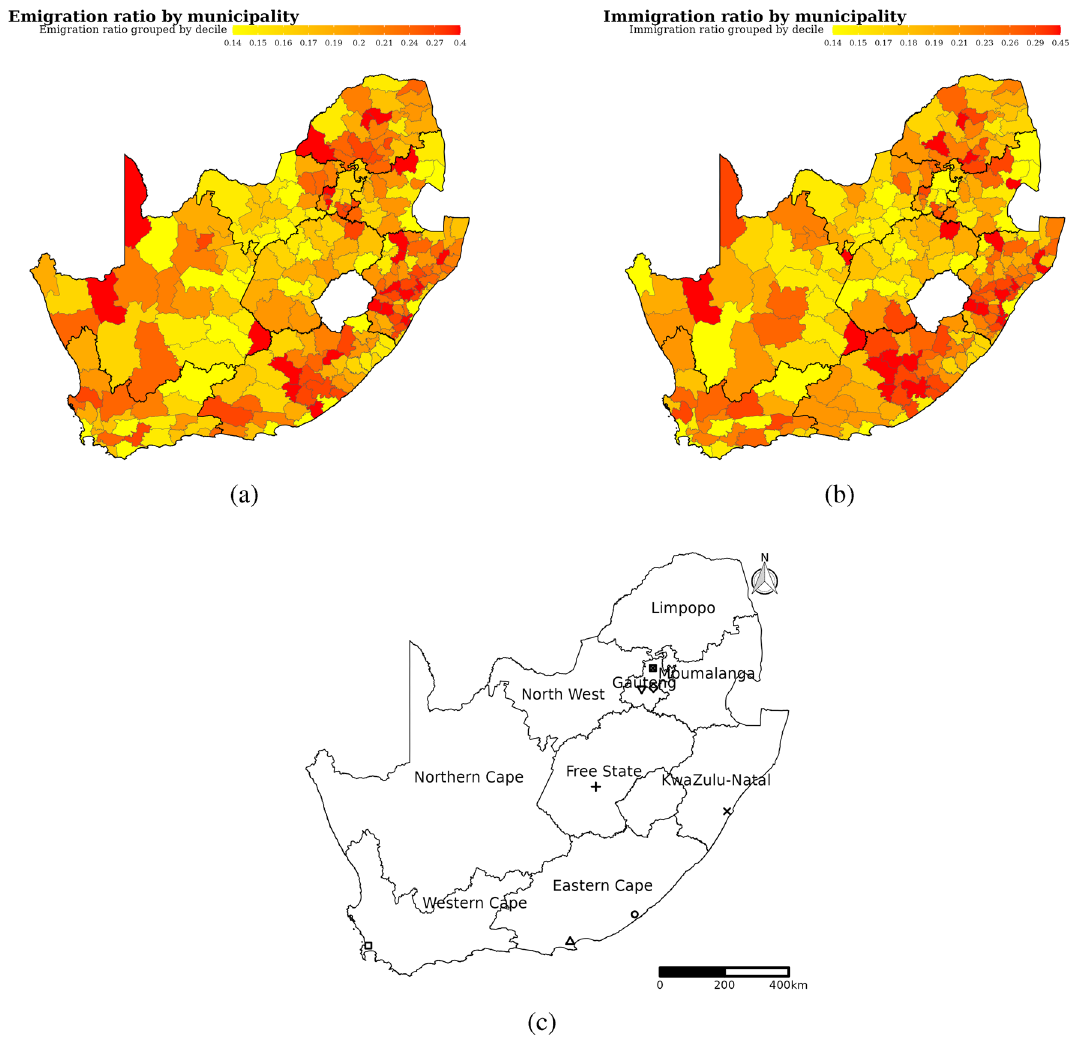
Figure 2. Emigration ( a ) and immigration ratios ( b ) by municipality among people with laboratory-diagnosed TB, and map of South Africa showing provincial boundaries and major cities ( c ). We calculated municipality- level emigration ratio as the share of outmigrants among people who initially visited a municipality, and immigration ratio as the share of in-migrants among all people who subsequently visited a municipality. We used laboratory tuberculosis test results, which were linked to identify individuals, from South Africa’s National Health Laboratory Service database to assess cross-municipality migration among people with laboratory- diagnosed tuberculosis. We defined migrants as people with laboratory-diagnosed tuberculosis who submitted tuberculosis test samples to clinics located in more than one municipality. The symbols in ( c ) are major cities in South Africa: Square, circle, triangle point up, plus, cross, diamond, triangle down, and square cross symbols are city of Cape town, Buffalo city, Nelson Mandela Bay, Mangaung, Ethekwini, Ekurhuleni, city of Johannesburg, and city of Tshwane